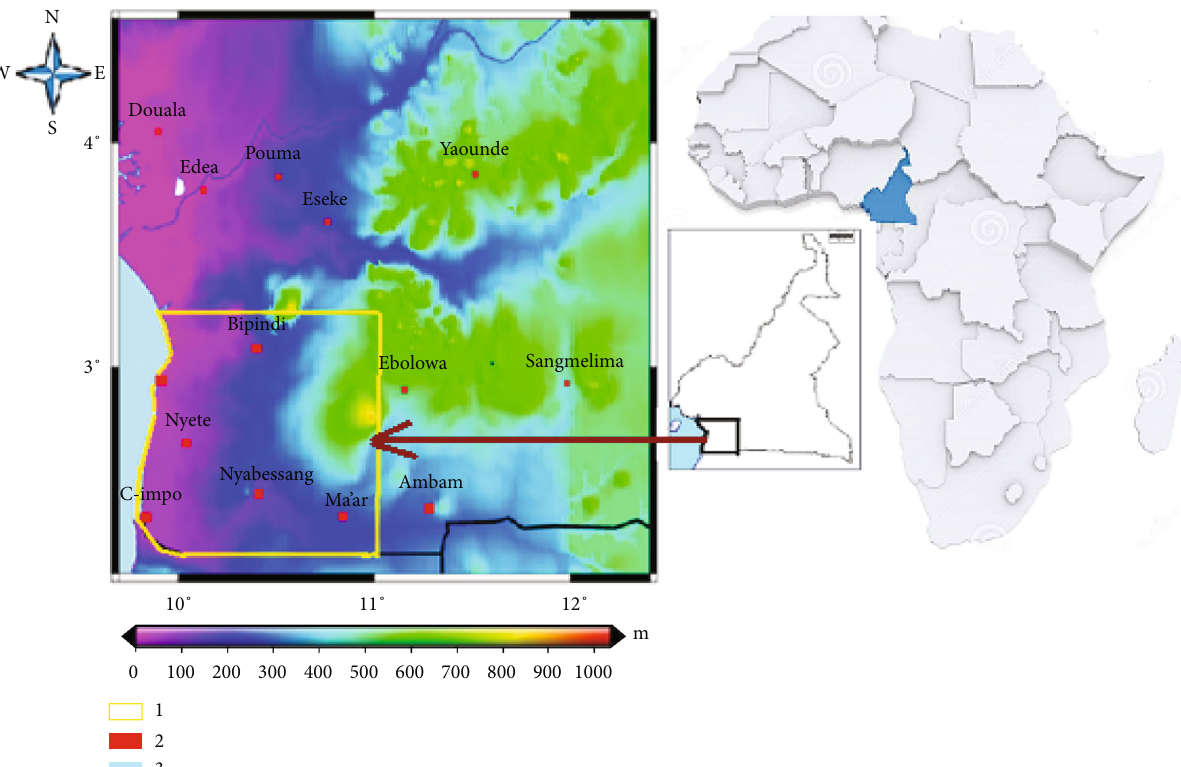
Figure 1: Location map of the study